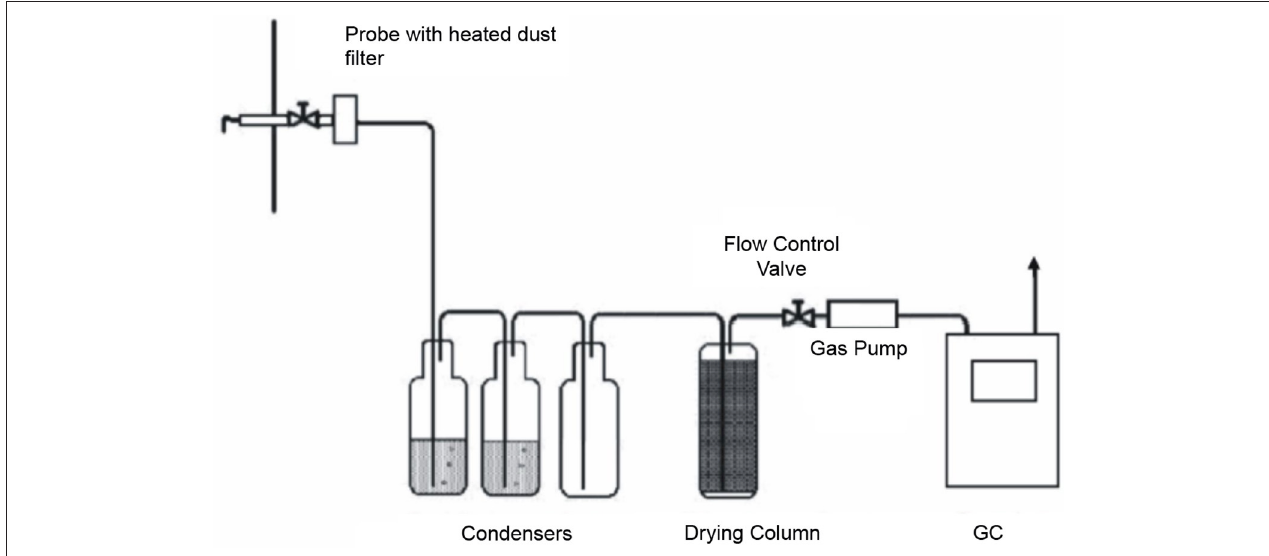
FIGURE 4 | Schematic of tar collection